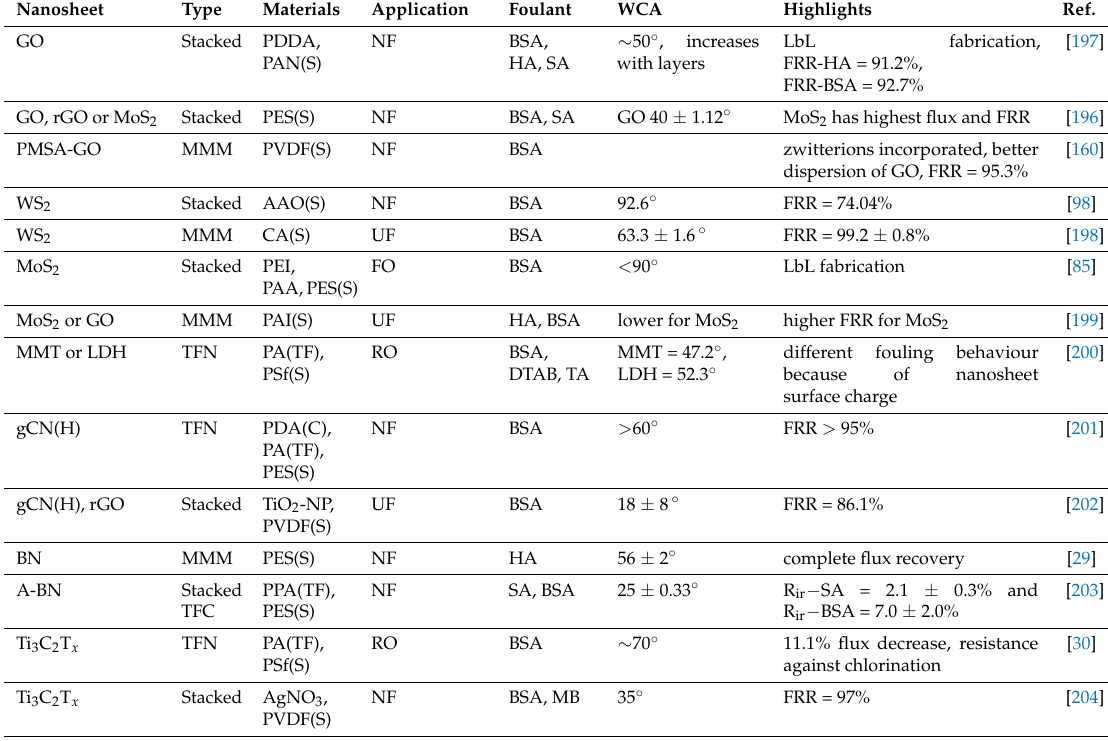
Table 1. Nanosheet membranes to mitigate non-migratory fouling.